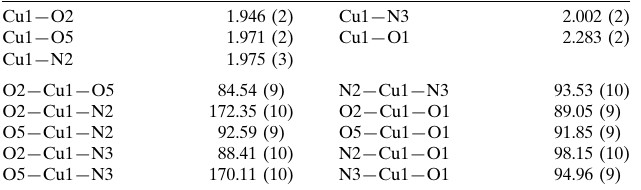
Selected geometric parameters (A˚ , (cid:1) ).